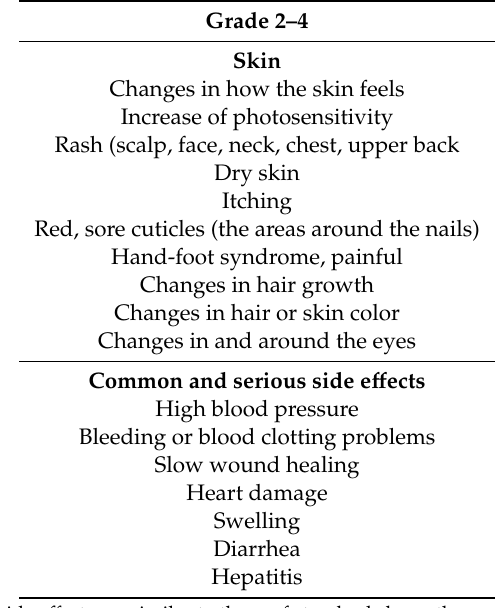
Table 3. Possible side e ff ects from targeted small molecule inhibitory